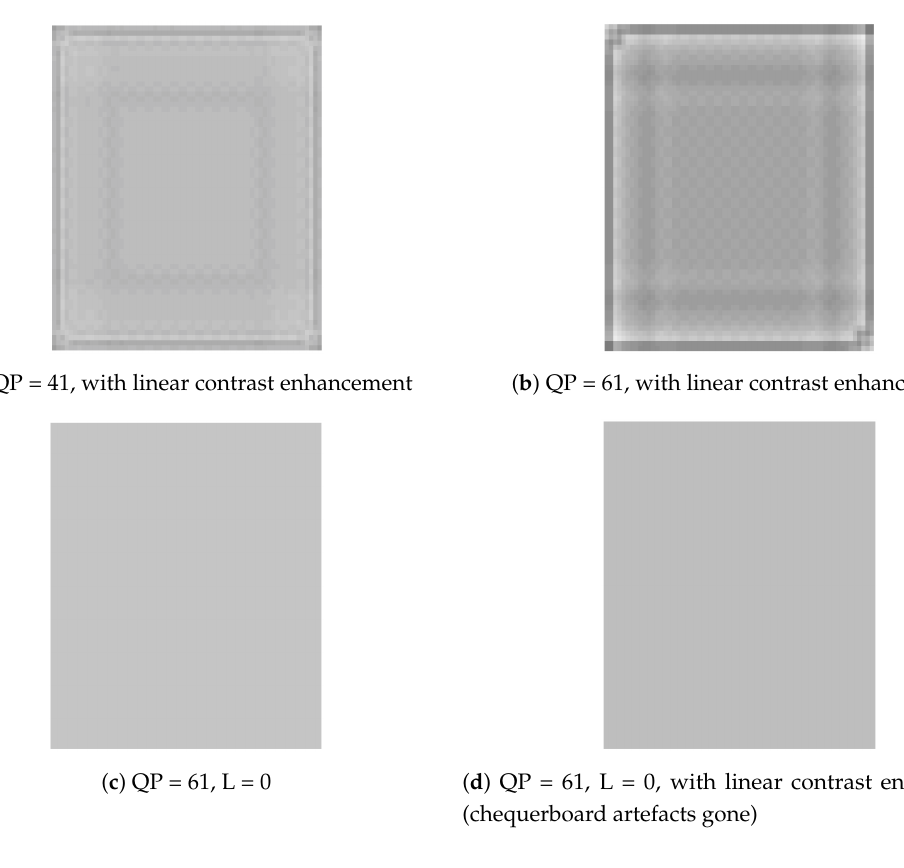
Figure 2. Part 2. Chequerboard